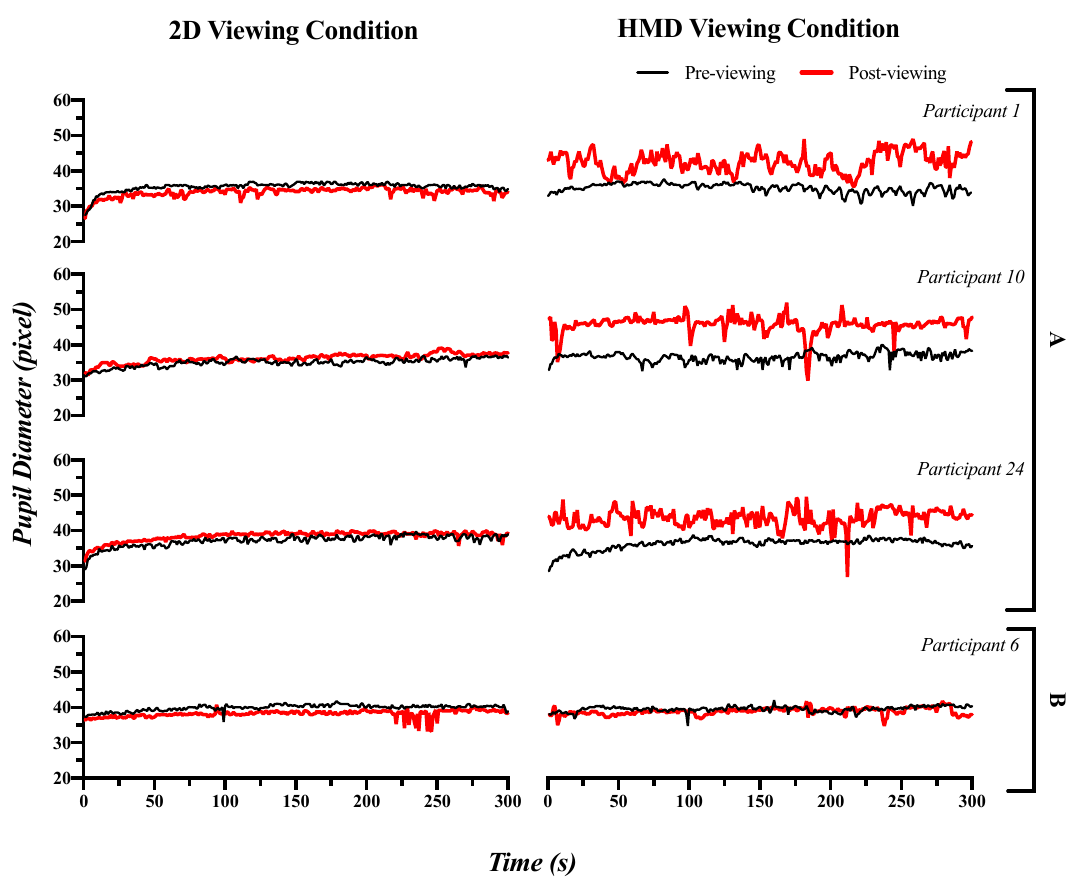
Figure 4. ( A ) Clear examples (for participants 1, 10 and 24) and ( B ) unclear example (for participant 6) of changes in pupillary rhythms (mPD and sPD) pre- and post-viewing 2D and HMD. A paired-sample t -test showed significant differences (increasing during the post- viewing measurement) for the mPD and sPD in the HMD viewing condition between the pre- and post-viewing measurements (mPD: t(46)) = − 11.544, p = 0.0000, with a large effect size (Cohen’s d = 3.404); sPD: t(46)) = − 8.265, p = 0.0000, with a large effect size (Cohen’s d = 2.437). In the 2D viewing condition, no significant differences were found between the pre- and post-viewing measurements (mPD: t(46) = − 0.645, p = 0.5251; sPD: t(46) = − 2.156, p = 0.0418]) based on the Bonferroni correction. The ANCOVA analysis showed a signifi- cant difference (increasing after the HMD condition) in the post-viewing condition for mPD and sPD with the pre-viewing condition as a covariate (mPD: F(1,46) = 90.793, p = 0.0000, with a large effect size ((cid:31)p 2 = 0.669); sPD: F(1,46) = 37.248, p = 0.0000, with a large effect size ((cid:31)p 2 = 0.453)), as shown in Figure 5 and Appendix A.